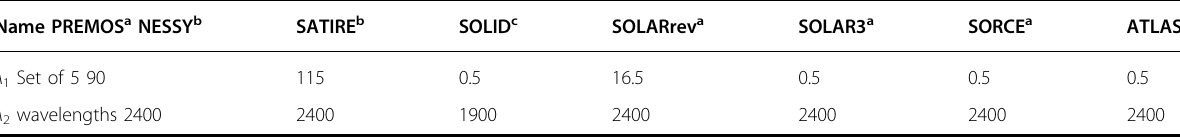
Table 1 Wavelength domains ( λ 1 to λ 2 ) per spectra used for this study, and their